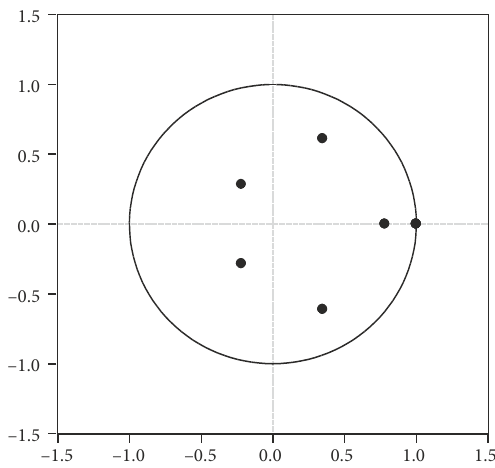
Figure 5. Inverse root stability plot for the estimated VEC model at 5% (source: authors’ own